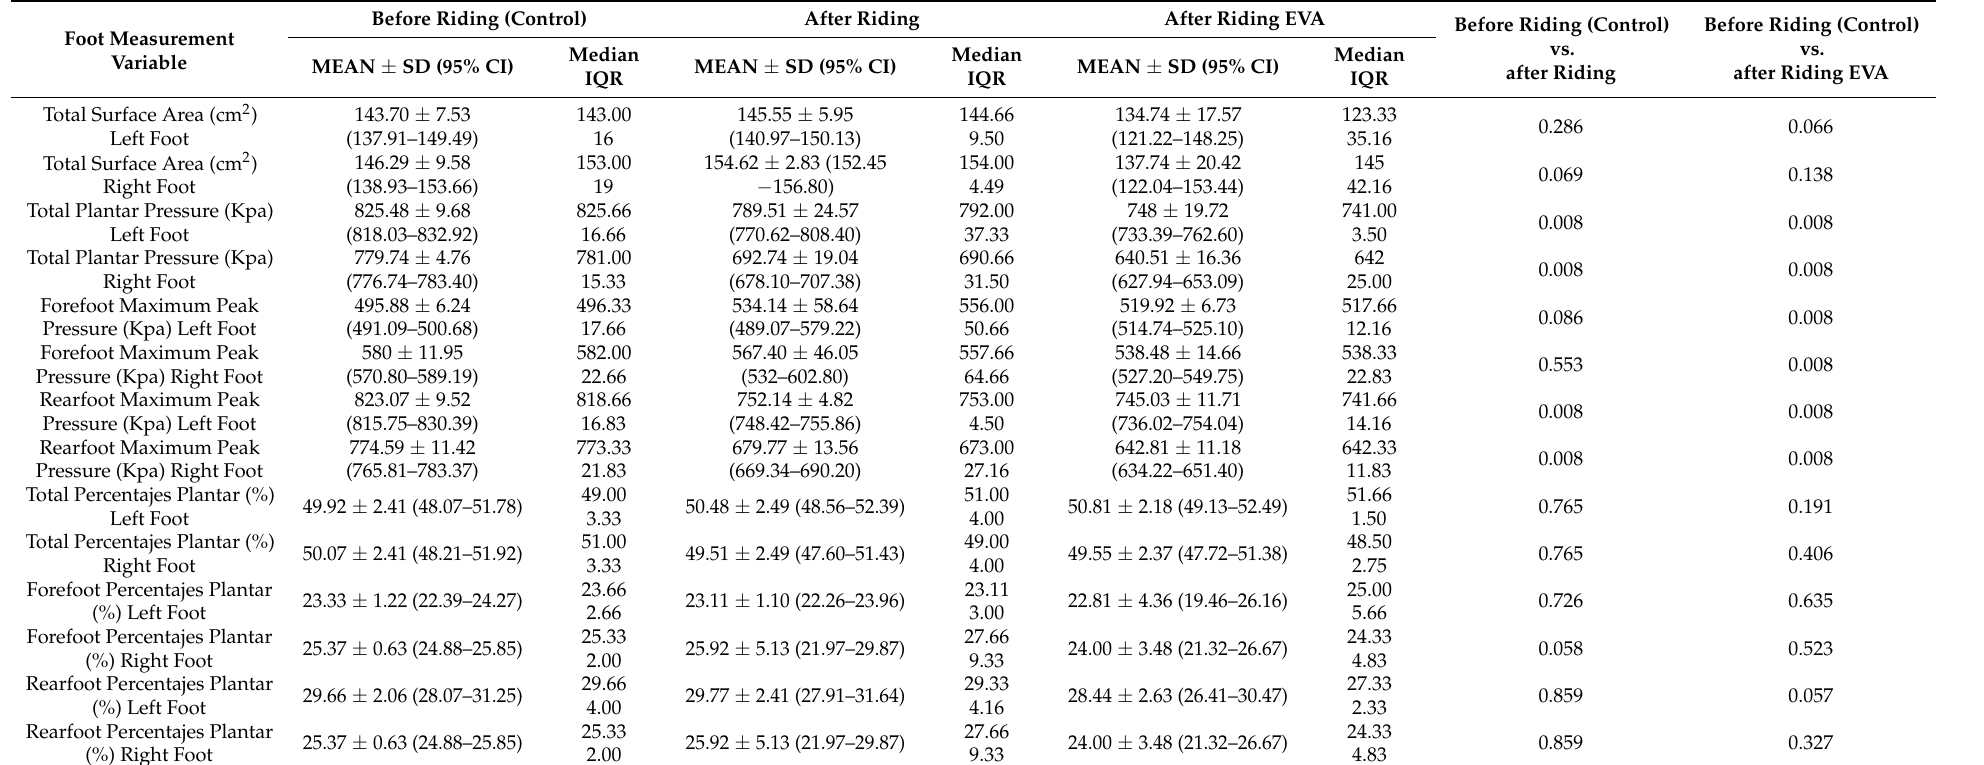
Table 4. Maximum plantar pressure and surface measured with podobarometric platform performed on right and left foot before riding on a Supersport motorcycle, after riding on a Supersport motorcycle with conventional insoles, and after riding with an EVA insole on a Supersport motorcycle, and comparisons values before and after riding on motorcycle in speed circuit with EVA